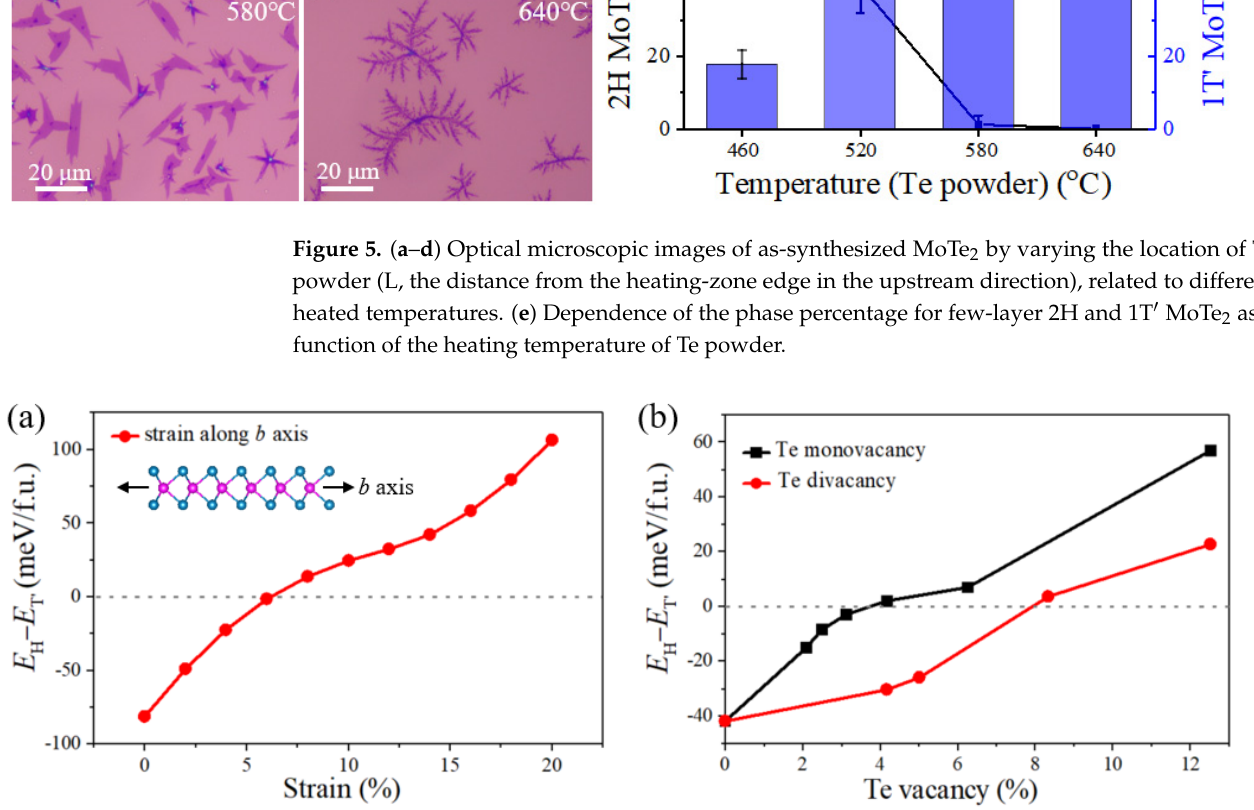
Figure 6. ( a ) The energy differences per formula between the 2H MoTe 2 and 1T’ MoTe 2 versus the strain along the b axis from the DFT calculation. ( b ) DFT calculation of the energy differences between the 2H and 1T’ MoTe 2 per formula as a function of the Te monovacancy (black line) and Te divacancy concentration (red line).